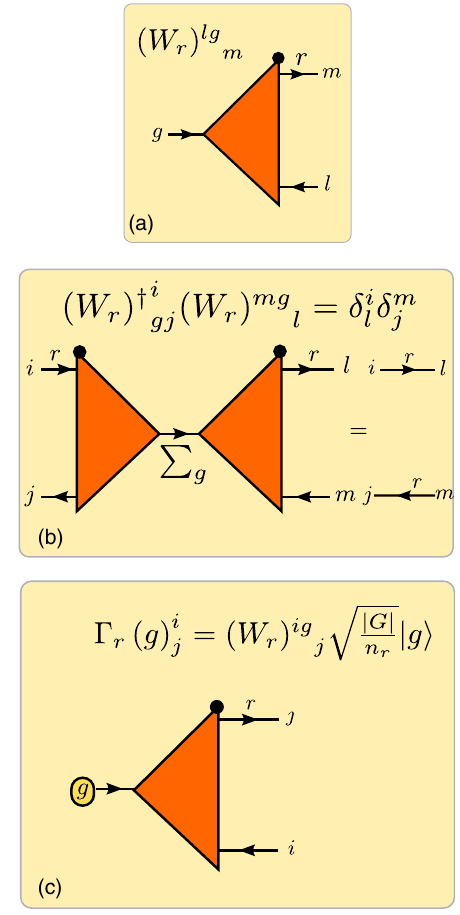
FIG. 3. (a) The orthogonality relation in Eq. (3) allows us to ⊗ ¯ V identify a set of isometries W projecting C ð g Þ onto V . If r r r g Þ for all g ∈ G , W one knows the matrices Γ is defined by r ð r collecting them inside a three-index tensor. The index r identify- ing the irrep is written on the top of one of the two legs. (b) The isometric property of the tensor W . (c) Alternatively, if we know r the W isometry, we can obtain the matrices in the r representa- r tion by acting with W on a vector proportional to j g i (yellow r circle in the figure). The resulting tensor has two indexes i and j g Þ i and is the matrix Γ r ð j